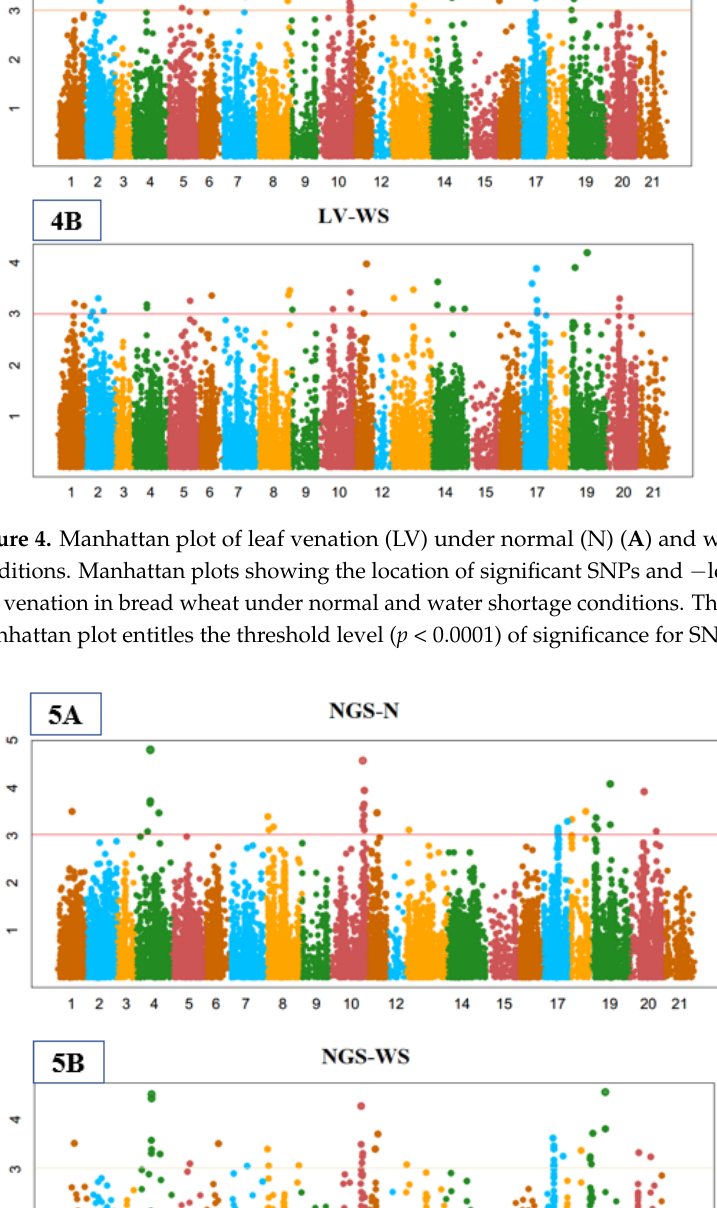
Figure 6. Manhattan plot of grain yield per plant (GYP) under normal (N) ( A ) and water shortage (WS) ( B ) conditions. Manha tt an plots showing the location of signi fi cant SNPs and − log10( p ) asso- ciated with grain yield per plant in bread wheat under normal and water shortage conditions. The red horizontal line on Manhattan plot entitles the threshold level ( p < 0.0001) of significance for SNPs with this trait.